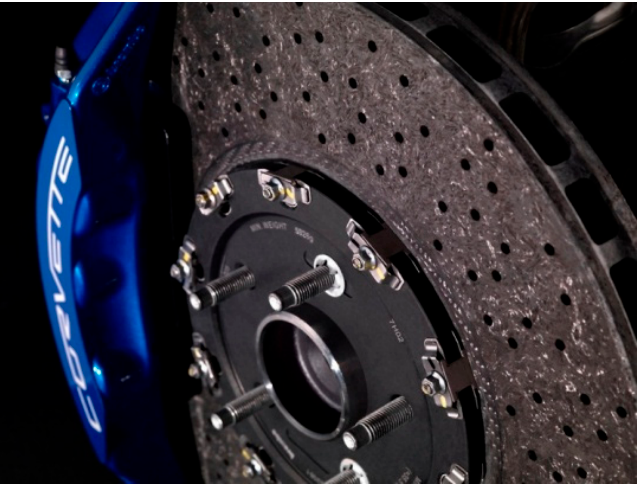
Figure 16. The braking system of corvette made of carbon–ceramic, which saved 4.9895 kg replacing iron, reproduced from [210] under open access license.